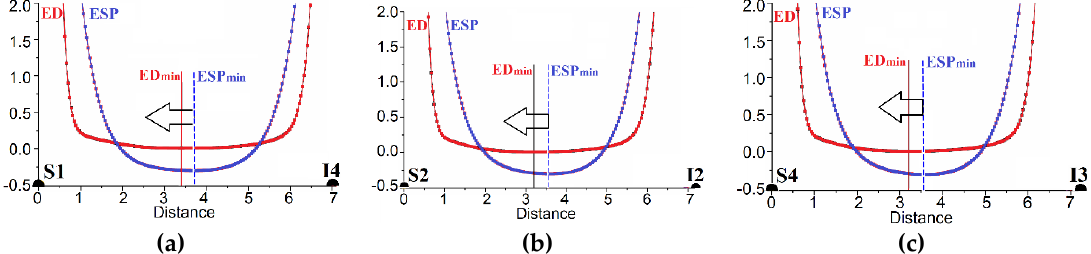
Figure 5. One-dimensional distributions of electron density (ED) and electrostatic potential (ESP) functions (a.u.) along the S ... I chalcogen bonds in 2a ( a ), 2b ( b ) and 2c ( c ) illustrating that the positions of electron density minimum (ED min ) are closer to the S atoms; interatomic distances are in Bohr.